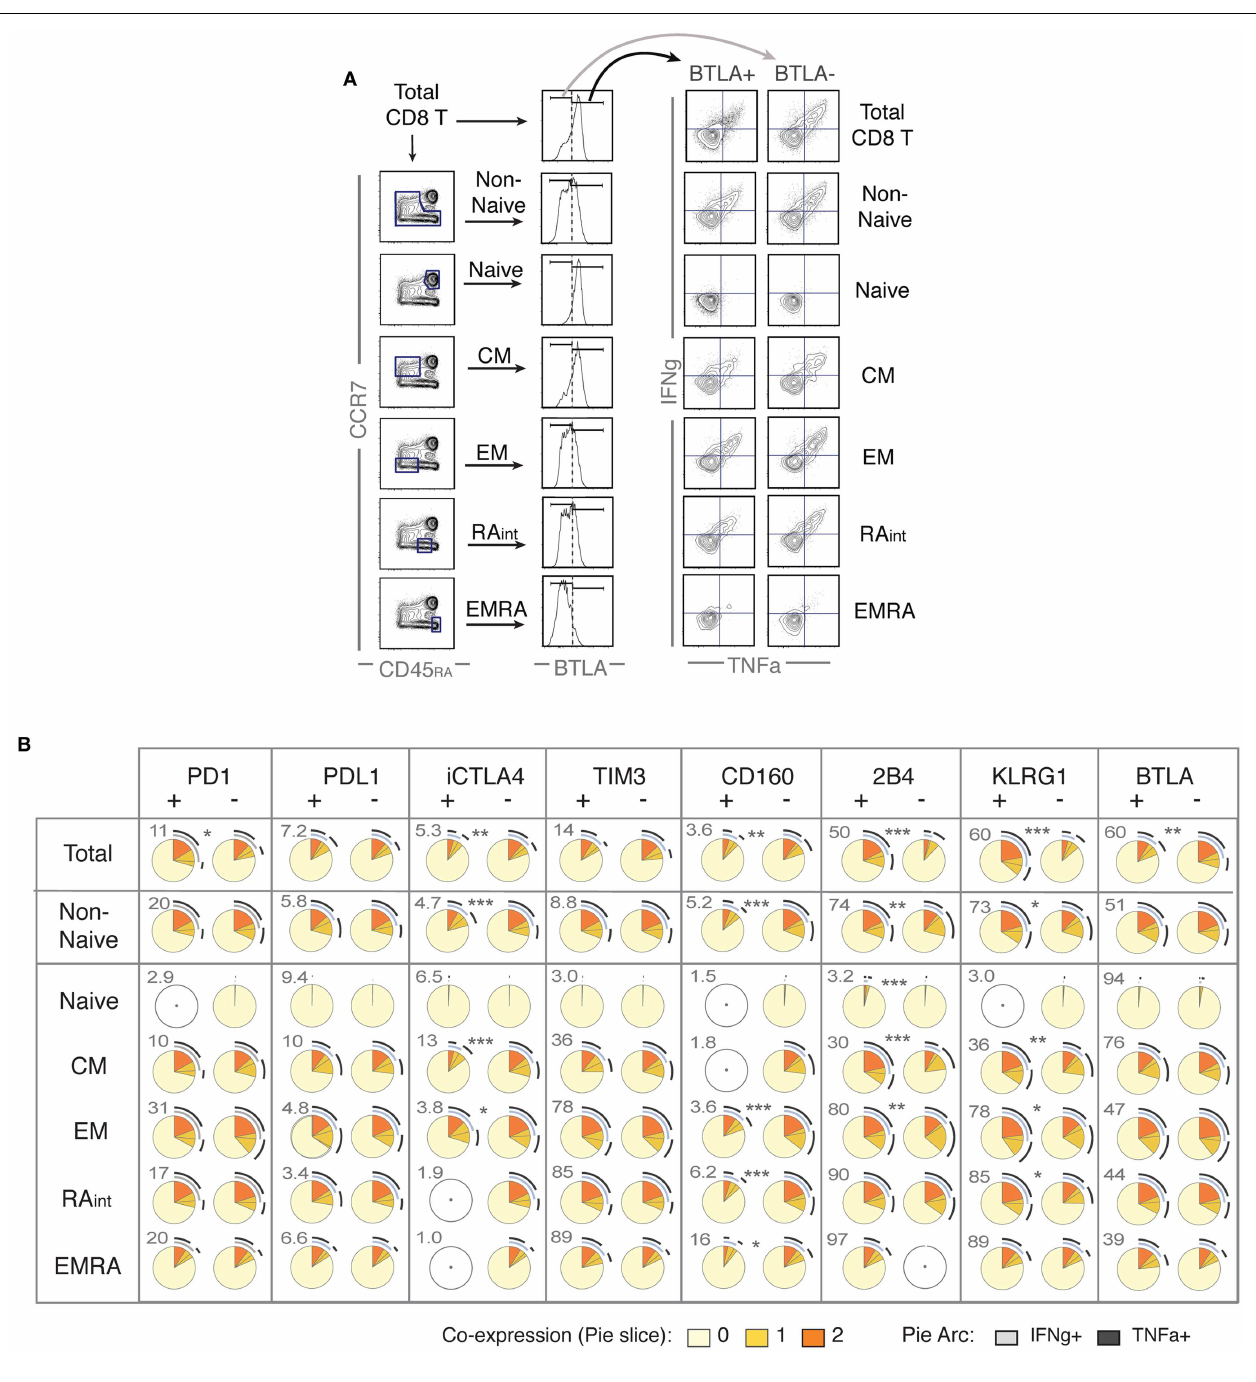
Non-Naïve, or in each of the differentiation subsets, as indicated in each row. Pie arcs and slices represent the percentage positive for IFNg and/orTNFa, as indicated in the legend.The numbers adjacent to the iR positive pies, above and to the left of each pie, indicate the % of iR positive cells within the differentiation gate considered. An empty gray circle means the population does not apply (i.e., only populations representing iR expression gates > 3% were considered).The p -values shown apply to the comparison of iR positive versus iR negative counterparts (indicated in between pairs of pies that showed